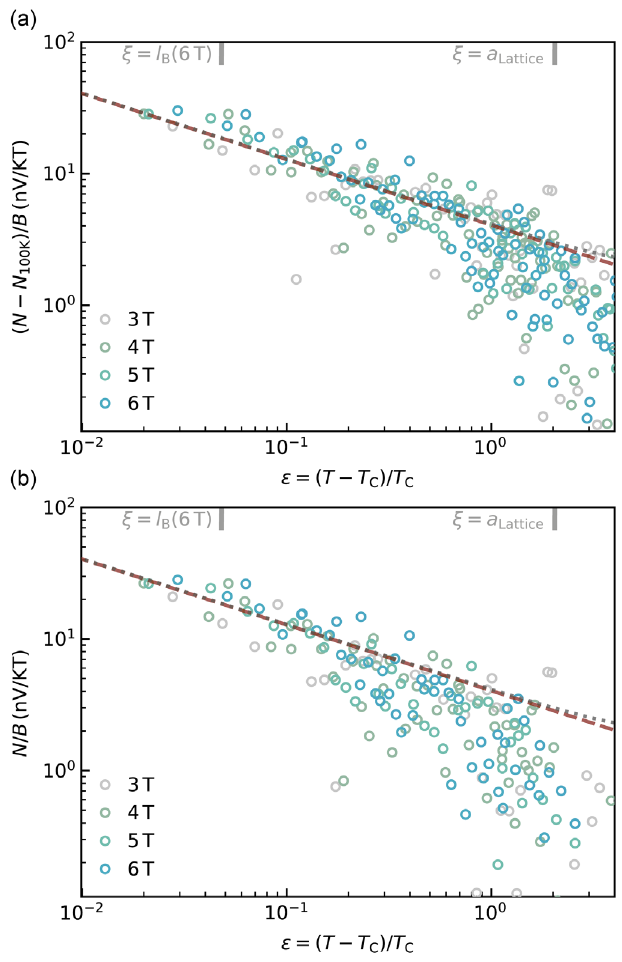
FIG. 9. Effect of subtracting the quasiparticle signal on the scaling analysis. (a) Same as Fig. 5(a), but subtracting the fixed value of N=B at 100 K instead of a temperature-dependent function. The gray dotted line shows the theoretical prediction of Eq. (2) but using a quadratic temperature dependence for the conductivity. (b) Nernst coefficient N=B without any subtraction of the quasiparticle contribution. Note that this results in some negative values for N at higher temperatures, which do not appear in this logarithmic